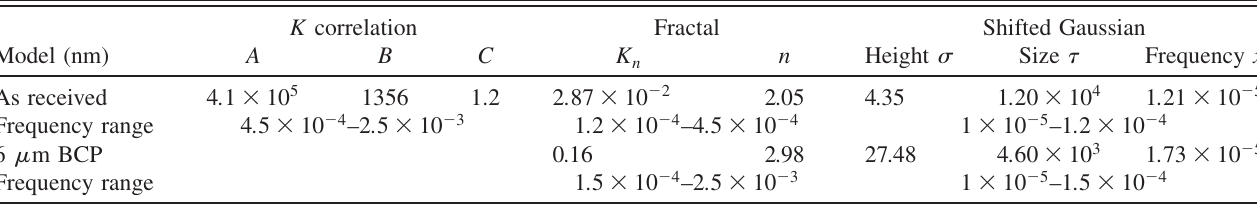
TABLE IV. The fitting parameter of samples (unit: nm) for Fig.